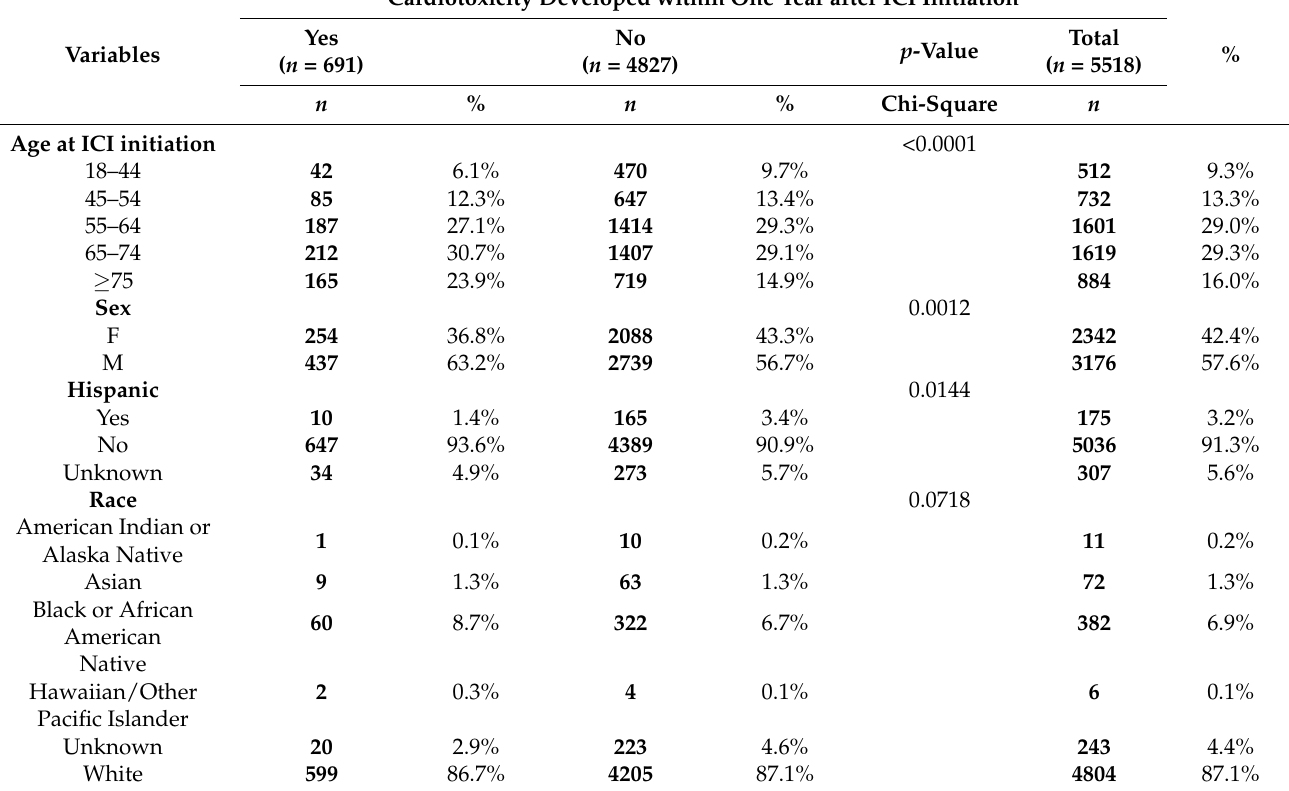
Table 1. Patient